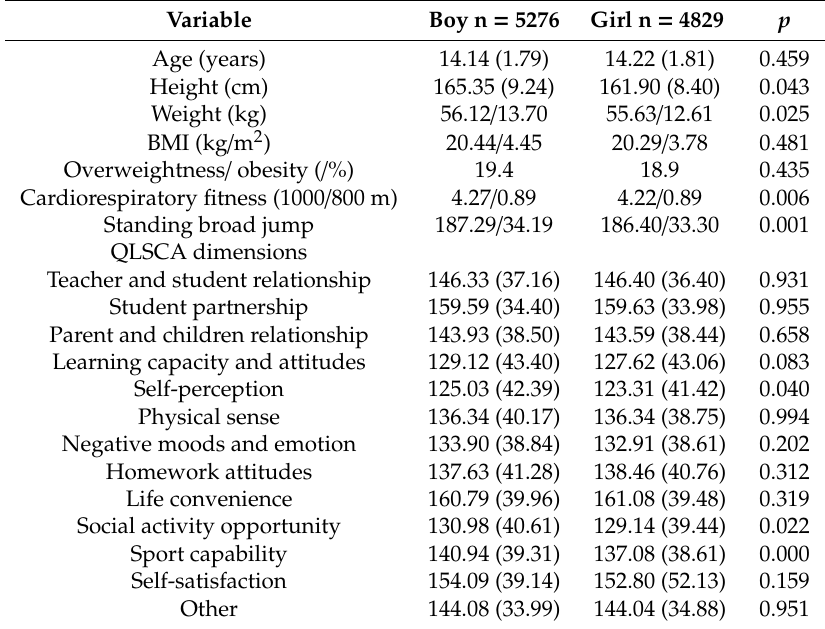
Table 1. Descriptive Characteristics and